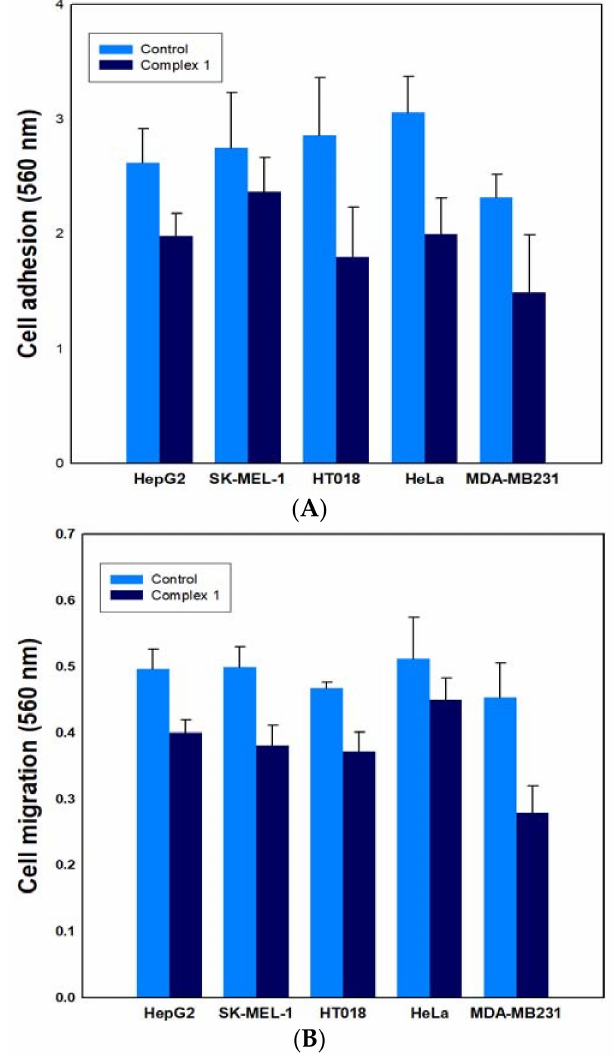
Figure 8. Effect of complex 1 on ( A ) cell adhesion and ( B ) cell migration against five cancer cell lines. Assays for adhesion and migration were performed with a cytoselect 24-well plate, and the absorbance of extracted samples was read at 560